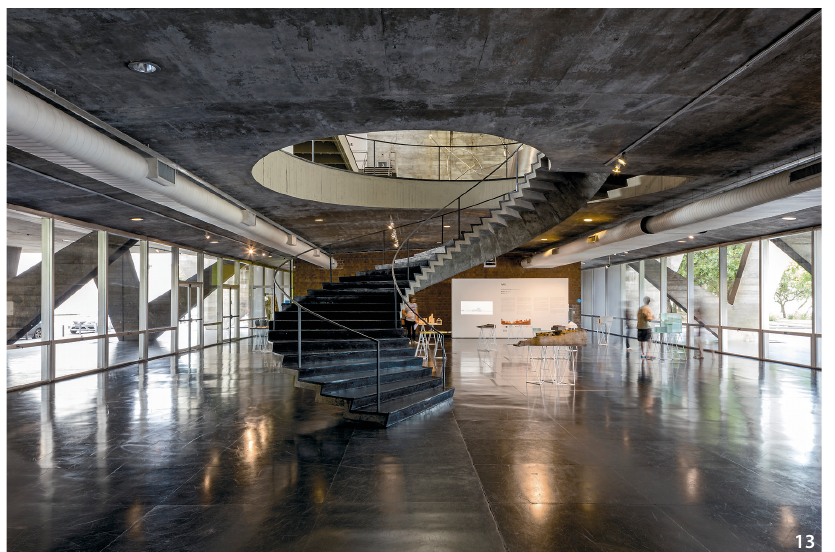
Figure 13 Affonso Eduardo Reidy, Museum of Modern Art, ground floor with ducts (Source: Leonardo